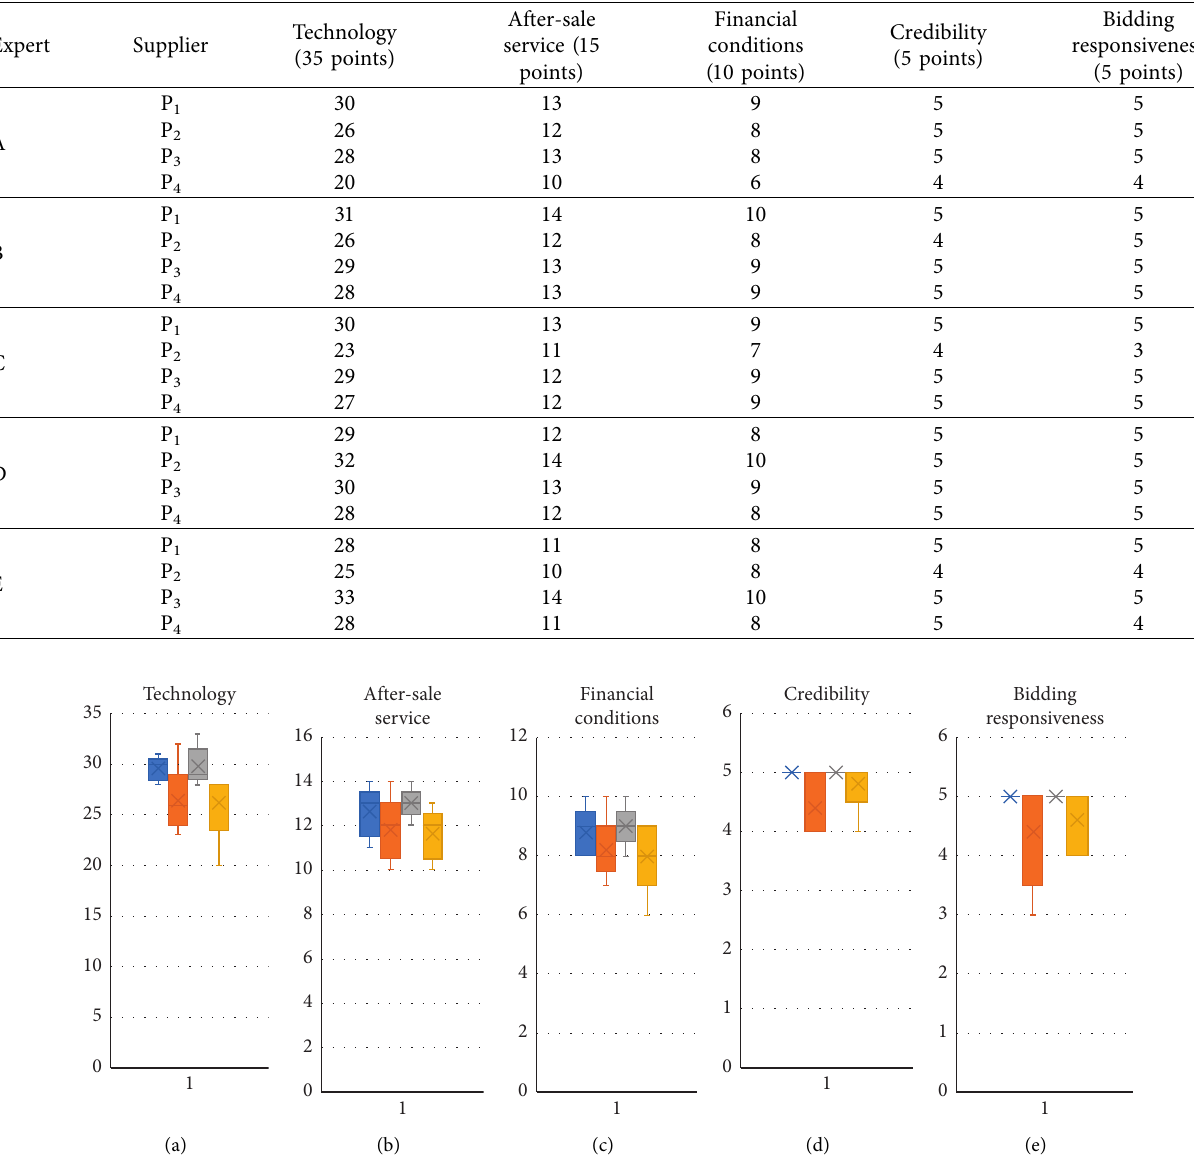
Figure 3: Distribution of evaluation data of experts